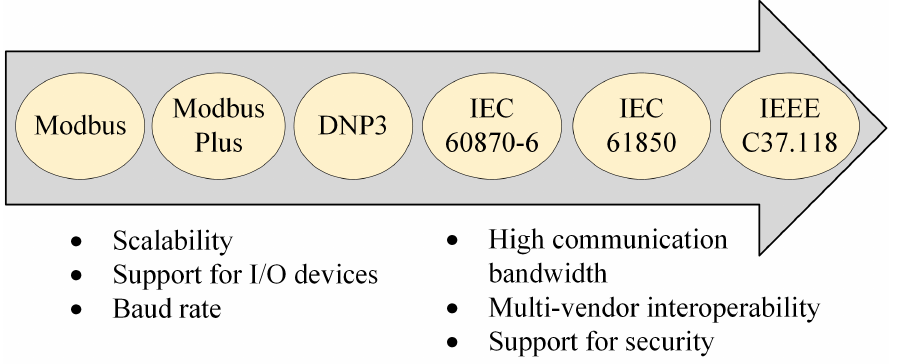
Figure 1. Different communication standards for the substation and SCADA